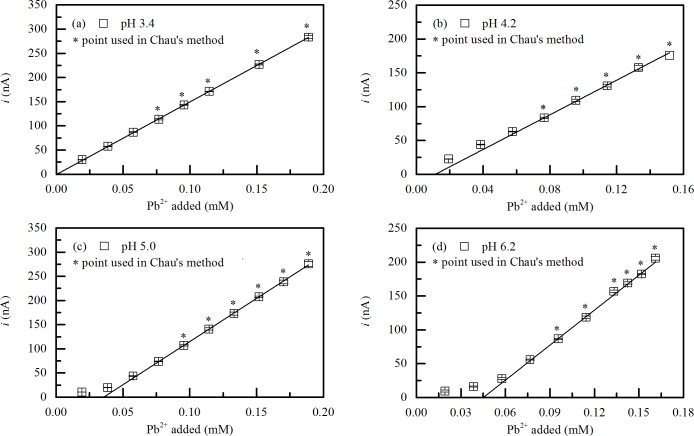
Plots of current i vs Pb2+ added for γ-PGA at (a) pH 3.4, (b) 4.2, (c) 5.0 and (d) 6.2 in 10 mM NaNO3.